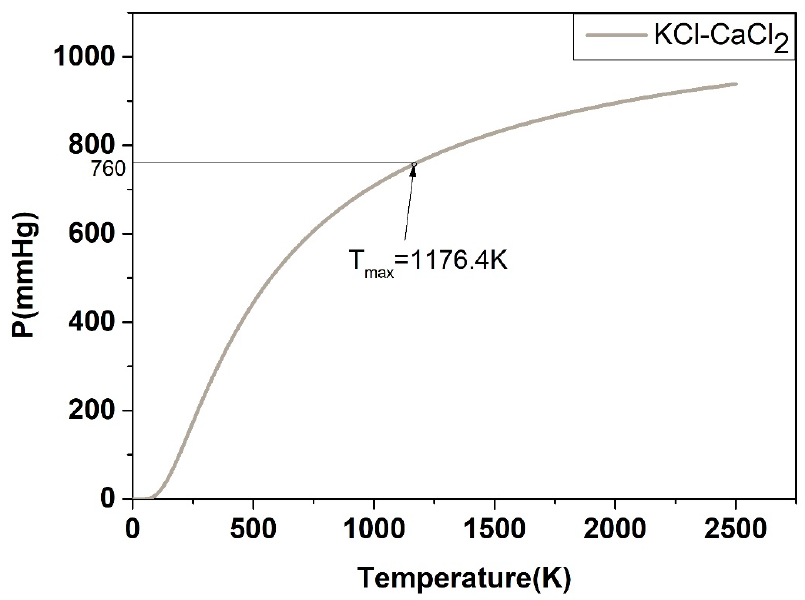
Figure 19. Calculated P-T phase diagram of the KCl-CaCl 2 binary system.